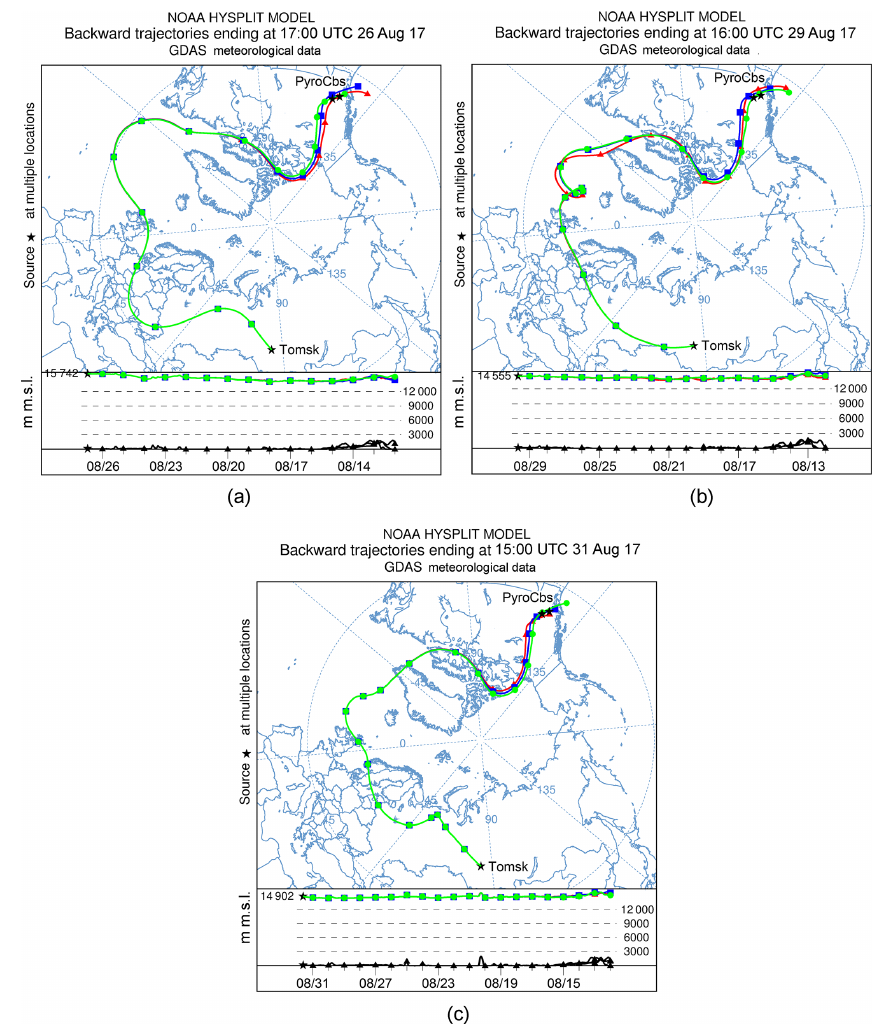
Figure 9. Air mass backward ensemble trajectories started from altitude of (a) ∼ 15 . 75km over Tomsk at 17:00UTC on 26 August 2017, (b) ∼ 14 . 55km at 16:00UTC on 29 August 2017, and (c) ∼ 14 . 9km at 15:00UTC on 31 August 2017.